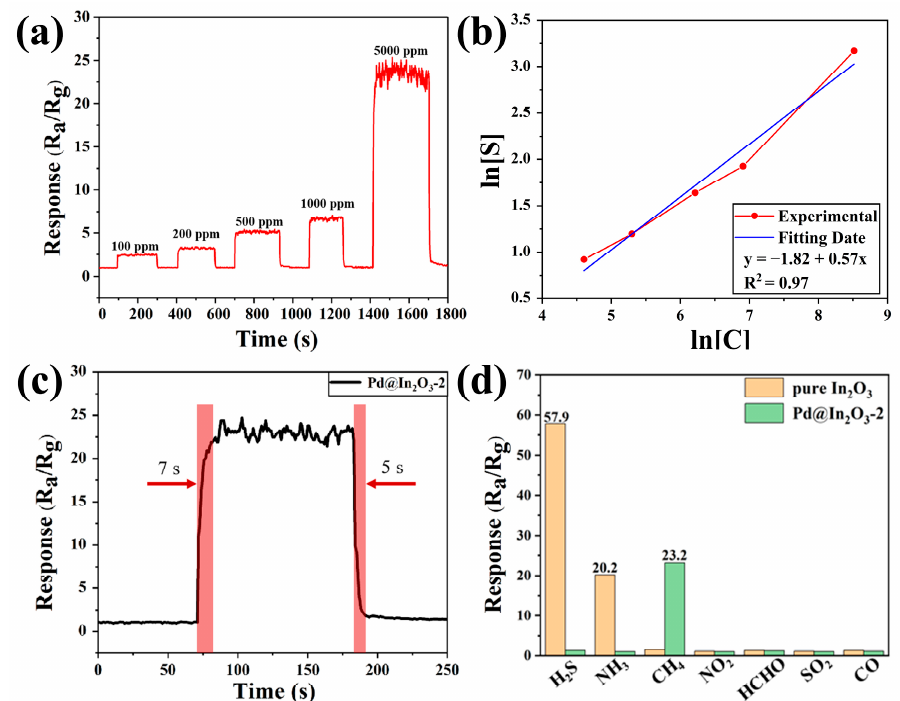
Figure 7. ( a ) Responses of Pd@In 2 O 3 -2 towards different concentrations of methane; ( b ) the linear fitting between ln[C] and ln[S]; ( c ) response and recovery time of Pd@In 2 O 3 -2 when exposed in 5000 ppm methane; ( d ) responses of pure In 2 O 3 and Pd@In 2 O 3 -2 to 5000 ppm methane and other interfer- ing gases.